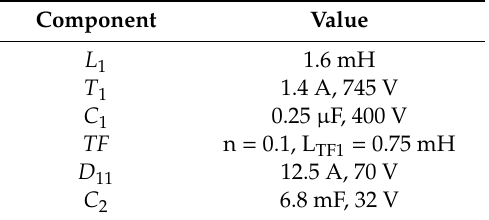
Table 2. Parameters of the main converter components.